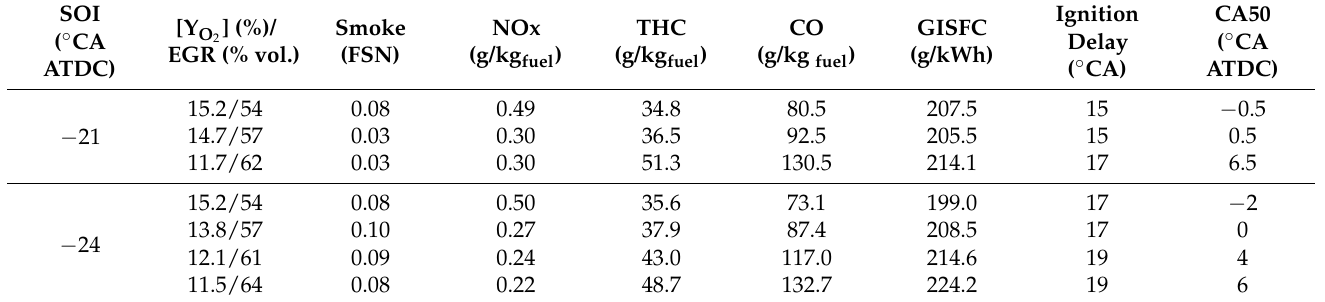
Table 3. Test points at a fixed SOI with minor variations in the EGR levels (Constant engine